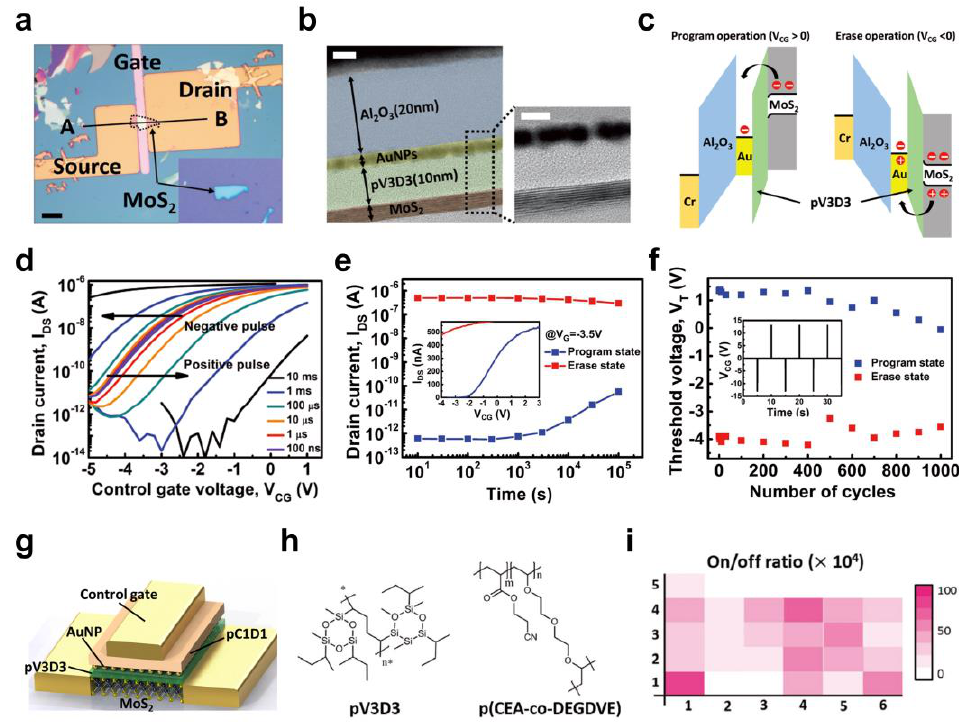
Figure 5. ( a ) Optical microscopy (scale bar: 10 μm) and ( b ) cross − sectional transmission electron microscopy (TEM) images (scale bar: 5 nm) of the 2D MoS 2 flash memory. ( c ) Electronic band diagrams for programming and erasing operations. ( d ) The change in the transfer curves in relation to the positive/negative pulse width ( V G = ±13 V), ( e ) the change in I D with respect to time, and ( f ) the change in V T monitored in repetitive programming/erasing cycles [40]. Copyright © 2017, John Wiley and Sons. ( g ) Schematic illustration of the 2D MoS 2 flash memory based on the polymer dielectric films and ( h ) chemical structures of the polymer materials. ( i ) The I on / I off distribution of the fabricated C − memory devices [109]. Copyright © 2019, John Wiley and Sons.